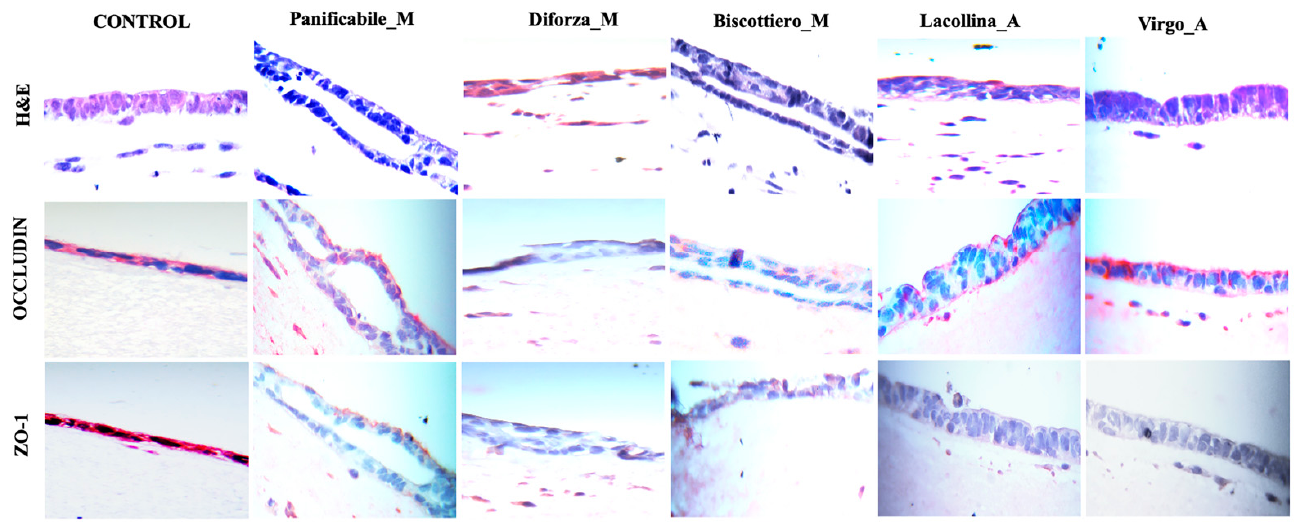
Figure 7. Hematoxylin and eosin (H & E), occludin, and zonula occludin-1 ZO-1 staining of 3D intestinal equivalents (Caco-2/U937/L929 co-cultures) exposed to no added protein (control) or 40 µg/mL total protein from three commercially available modern wheat mixes (denoted by M) and two heritage wheat mixes (denoted by A) for a period of 24 h. For occludin and ZO-1 staining, fast red was used as a chromogen and nuclei were counterstained with eosin. The magnification was ×40.